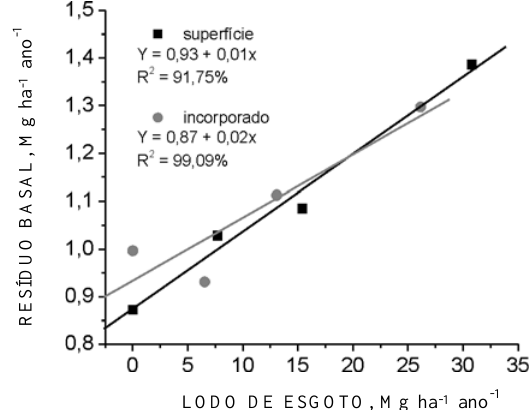
Figura 2. Produção anual de resíduo basal (palmito caulinar) de acordo com as doses de lodo de esgoto aplicadas anualmente, em superfície ou incorporadas, durante a fase de manutenção da cultura da